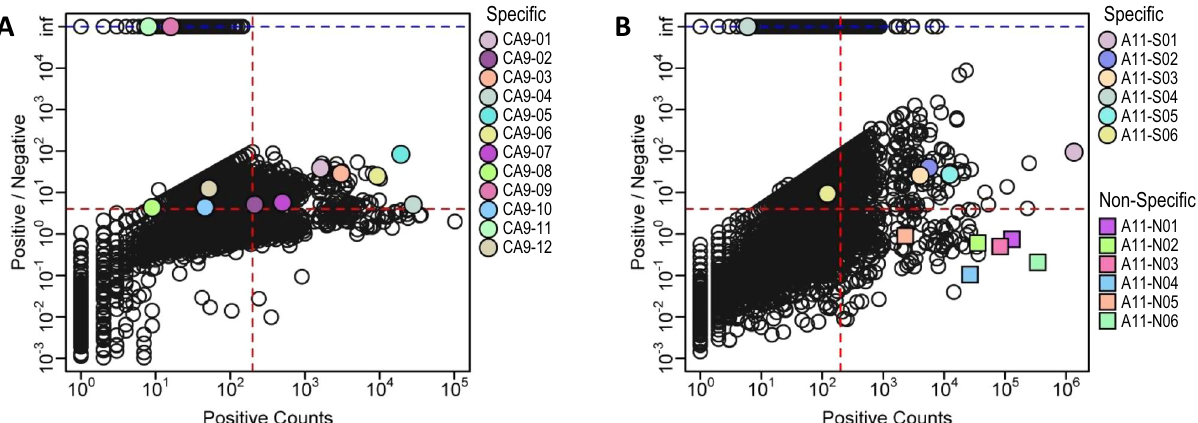
Fig. 6 Predicted unique Ab clones by CellectSeq on CA9 and integrin- α 11 NGS data. A , B Each circle represents a unique Ab clone (i.e., a unique combination of CDRs L3, H1, H2, and H3) generated by NGS. The abundance of each sequence in the Fab-phage pool selected for binding to target antigen overexpressing cells (x-axis: positive counts) is plotted versus the ratio of the abundance in the pool selected for binding to antigen overexpressing cells over pools selected for binding to parental cells (y-axis: positive/negative). The dashed blue line (y-axis: inf) corresponds to the clones with zero observations in the negative pool. The dashed red lines de fi ne an upper-right quadrant that contains putative binding clones, de fi ned arbitrarily as those occurring more than 200 times in the positive pool and being greater than fourfold enriched relative to the negative pool. In contrast to Fig. 3, the dashed red lines here serve only as visual references to inspect the individual enrichment level of the clones predicted by CellectSeq as highly speci fi c ( p value < 10 − 10 ). A Predicted unique Ab clones by CellectSeq on CA9 NGS data. Colored solid circles (N:257,692) represent the twelve clones from distinct families of L3/H3 sequences (>80% sequence identity in L3 and H3) predicted with the highest speci fi city (lowest p value <10 − 10 ). Speci fi city for CA9 was predicted by CellectSeq and validated by cellular phage ELISA. B Predicted unique Ab clones by CellectSeq on integrin- α 11 NGS data. Colored solid circles (N:108,441) represent the six non- homolog clones (>80% sequence identity in L3 and H3) predicted with the highest speci fi city (lowest p value <10 − 10 ). Colored solid squares represent the six most enriched clones from distinct families of L3/H3 sequences (>80% sequence identity in L3 and H3) in the positive pool predicted as nonspeci fi c (highest p value >10 − 3 ). Speci fi city for integrin- α 11 was predicted by CellectSeq and validated by cellular phage